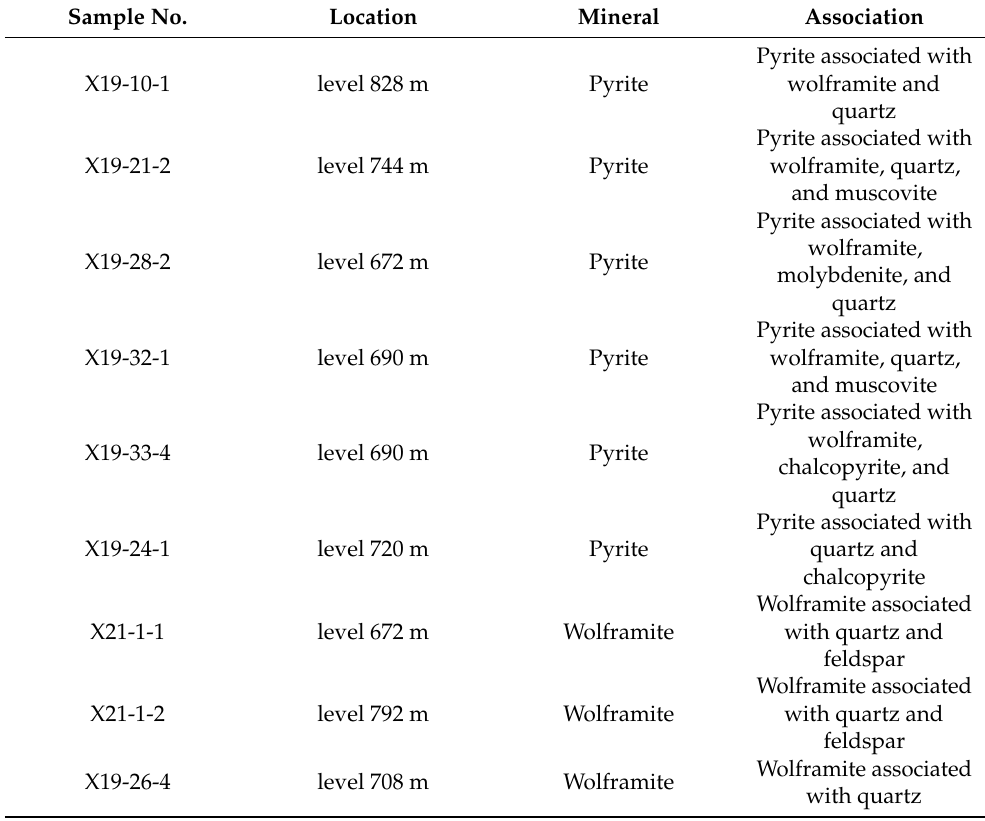
Table 1. Location and description of samples used for this study. Sample